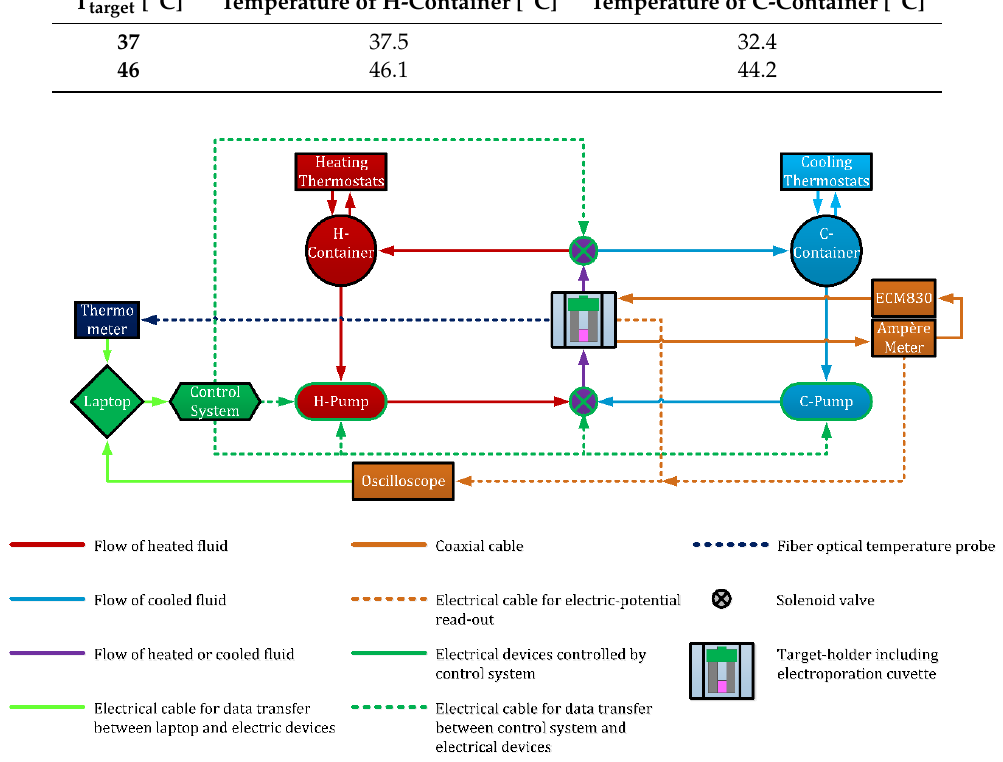
Table 1. Average temperatures of the demineralized water in the heating (H) and cooling (C) containers. These temperatures depend on the target temperature (T target [°C]) and IRE settings. The temperatures of H-containers were used for both 500 V ⋅ cm −1 and 1,250 V ⋅ cm −1 , while temperatures of C-containers were only used for 1,250 V ⋅ cm −1 .